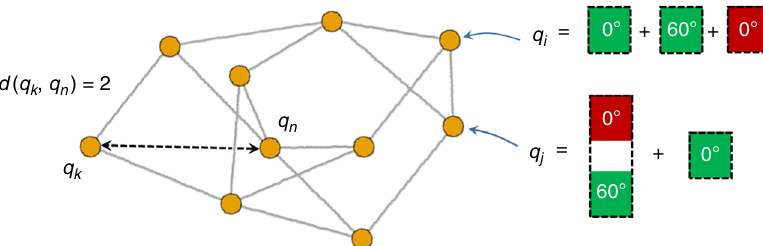
Fig. 3 A simpli fi ed sketch of the island combination network. Vertices (circles) correspond to possible island combinations that can be formed from n adsorbed molecules (in this case, n = 3), and two vertices are connected by an edge if and only if they differ by the state of a single molecule. The graph distance d ( q i , q j ) is the length of the shortest path connecting vertices q i and q j . The island combination network is used to construct the dendrogram shown in Fig. 4 (see main text for